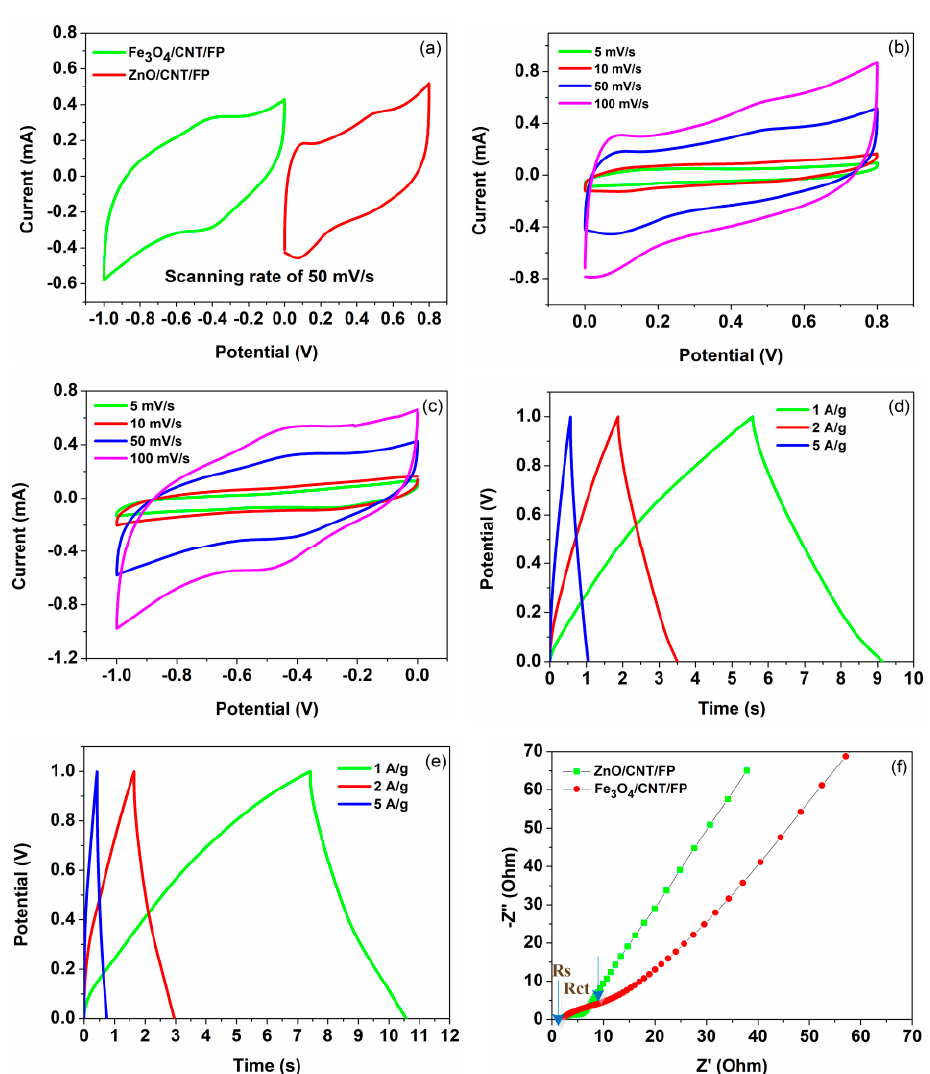
Figure 4. ( a ) Cyclic voltammetry (CV) curves of ZnO / CNT / FP and Fe 3 O 4 / CNT / FP electrodes at the scanning rate of 50 mV / s; ( b ) CV curves of ZnO / CNT / FP at di ff erent scanning rates; ( c ) CV curves of Fe 3 O 4 / CNT / FP at di ff erent scanning rates; ( d ) galvanostatic charge / discharge (GCD) curves of the ZnO / CNT / FP electrode at di ff erent current densities; ( e ) GCD curves of the Fe 3 O 4 / CNT / FP electrode at di ff erent current densities; ( f ) Nyquist plots of the ZnO / CNT / FP and Fe 3 O 4 / CNT / FP electrodes,